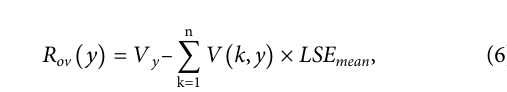
Frontiers in Environmental Science |